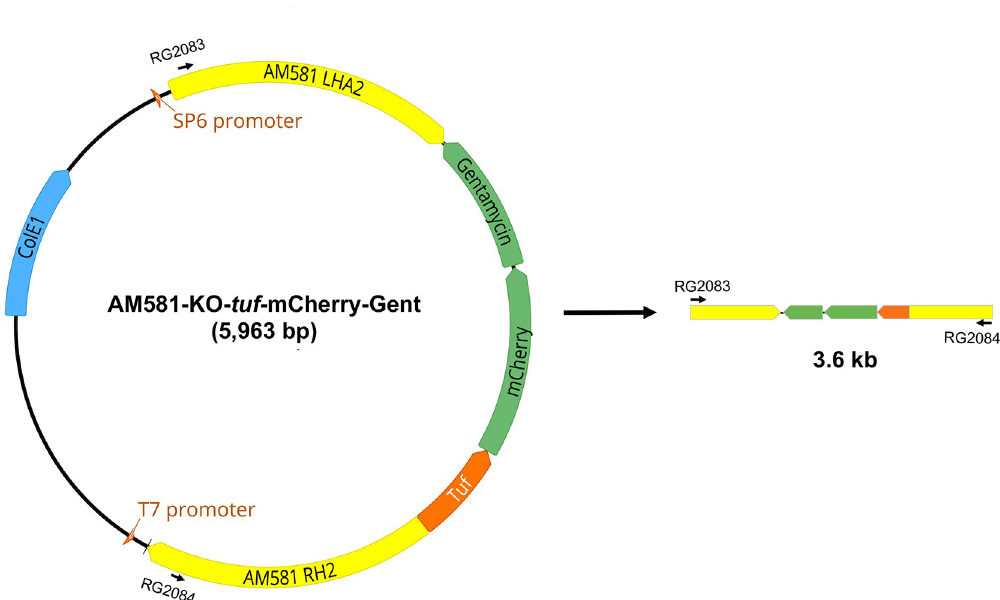
Fig 1. Plasmid map of AM581-KO- tuf- mCherry-Gent construct. Left and right homology arms for targeted allelic exchange are shown on the plasmid map. The segment containing the left and right homology arms separated by the E . chaffeensis tuf promoter segment to drive the expression of mCherry and gentamicin resistance cassette was amplified for use in allelic exchange homologous recombination.